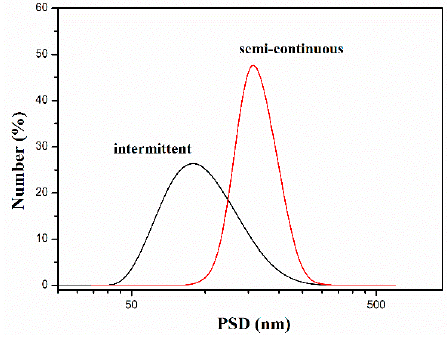
Figure 3. Effect of different emulsion polymerization methods on the particle diameter distribution (PSD).